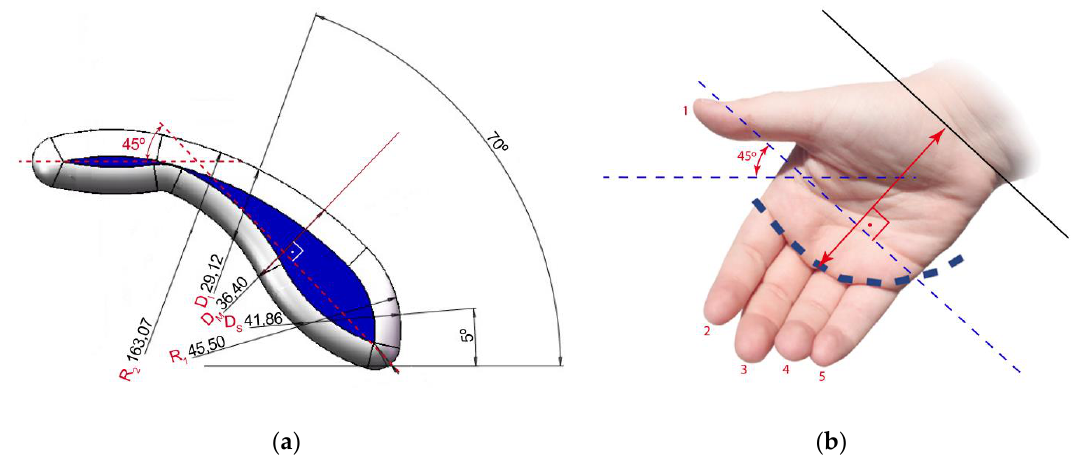
Figure 3. ( a ) Parameters used in the study; ( b ) directives for determining the handle position. (cid:9)